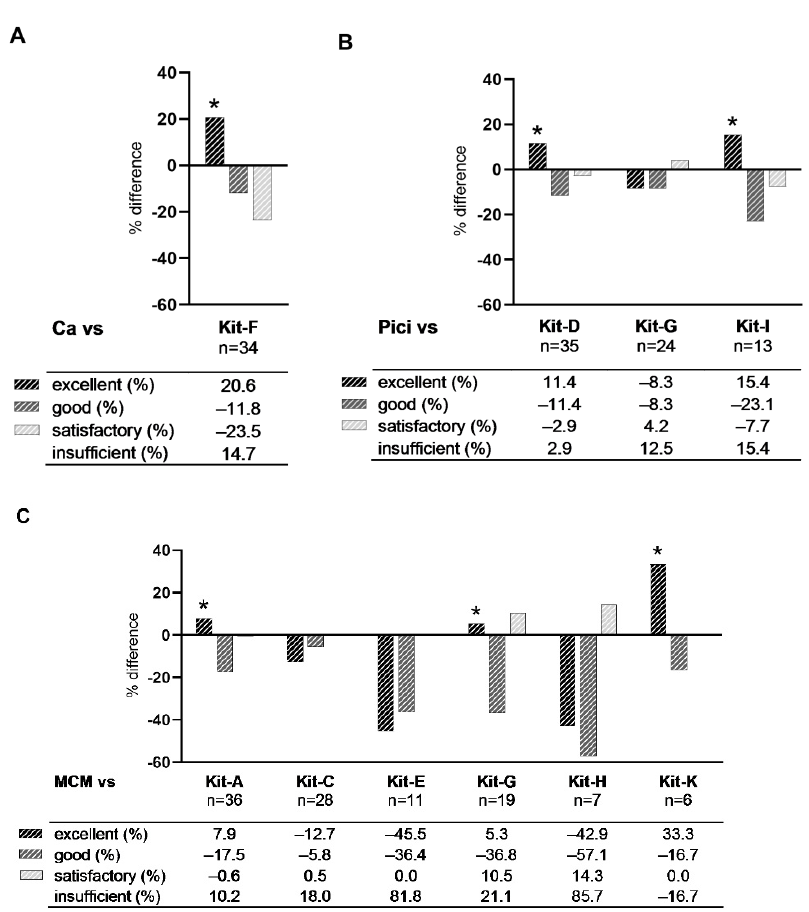
Figure 4. Comparison of DC/DC leu -generation from leukaemic WB with standard (Ca, Mcm, Pici) and new DC/DC leu -generating protocols (kits). Given are the percentual differences of proportions of cases with sufficient (excellent, good, satisfactory) and insufficient DC/DC leu -generation following the DC/DC leu -classification when comparing the standard protocol Ca with its derivative protocol Kit-F ( A ), Pici with its derivative protocols Kit-D, -G, -I ( B ), and Mcm with its derivative protocols Kit-A, -C, -E, -G, -H, -K ( C ). An increase of proportions of cases with excellent DC/DC leu -generation is marked with *.